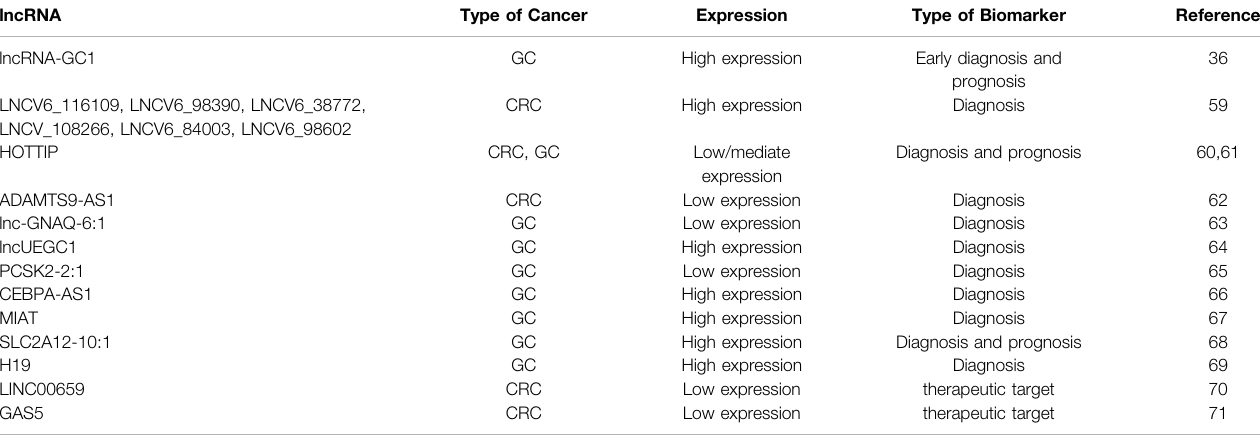
TABLE 2 | The clinical application of exosomal lncRNAs in gastrointestinal cancer.